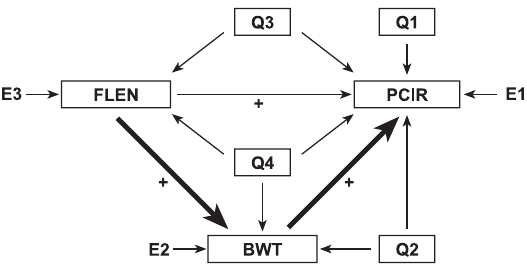
Figure 7. Structural Equation Model for Bone Geometry